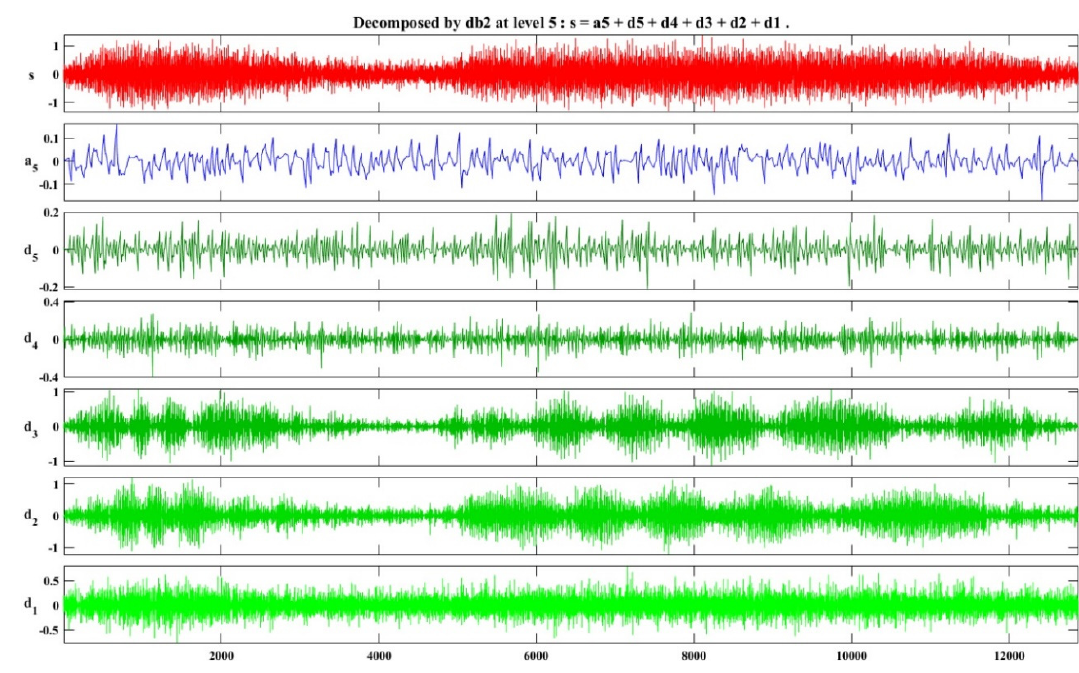
Figure 5. Wavelet decomposition result of the noisy signal.